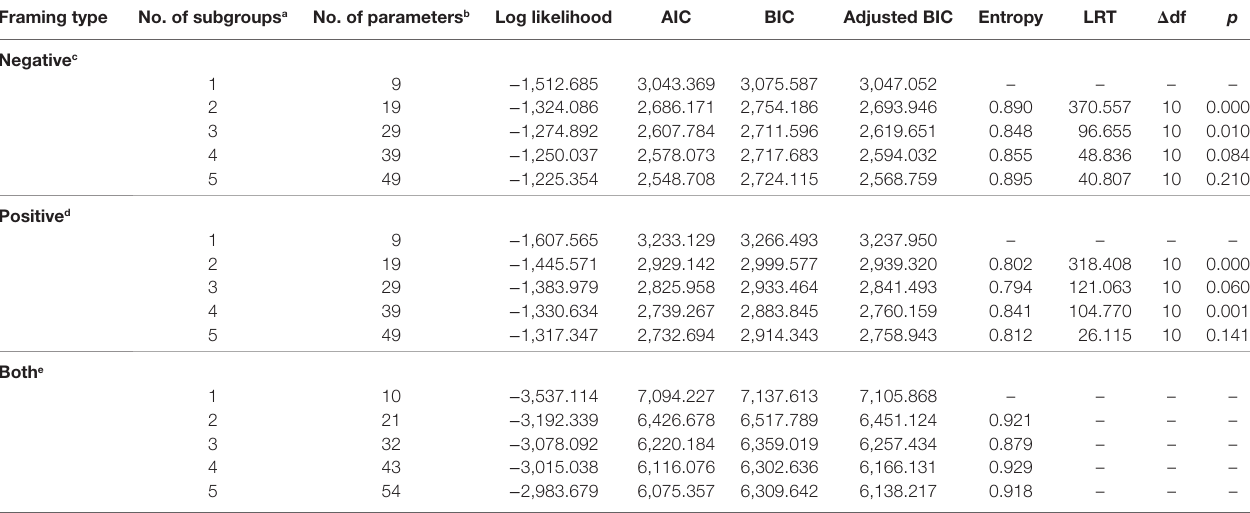
Table 2 | Model fit statistics for different subgroup models in the negative- and positive-framing groups and both groups combined. Framing